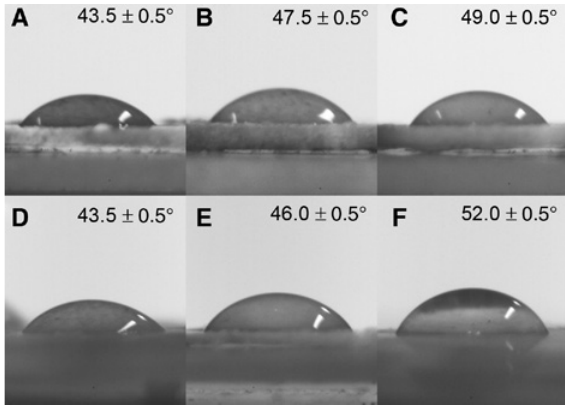
Figure 4: Contact angles of cationic OMts. (A) Contact angles of OMt (1.0)-D. (B) Contact angles of OMt (1.0)-S. (C) Contact angles of OMt (1.0)-W. (D) Contact angles of OMt (1.5)-D. (E) Contact angles of OMt (1.5)-S. (F) Contact angles of OMt